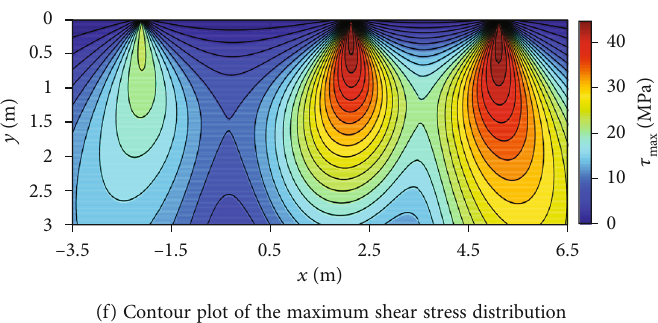
Figure 11: Stress evolution characteristics of surrounding rocks along the empty roadway before cutting the